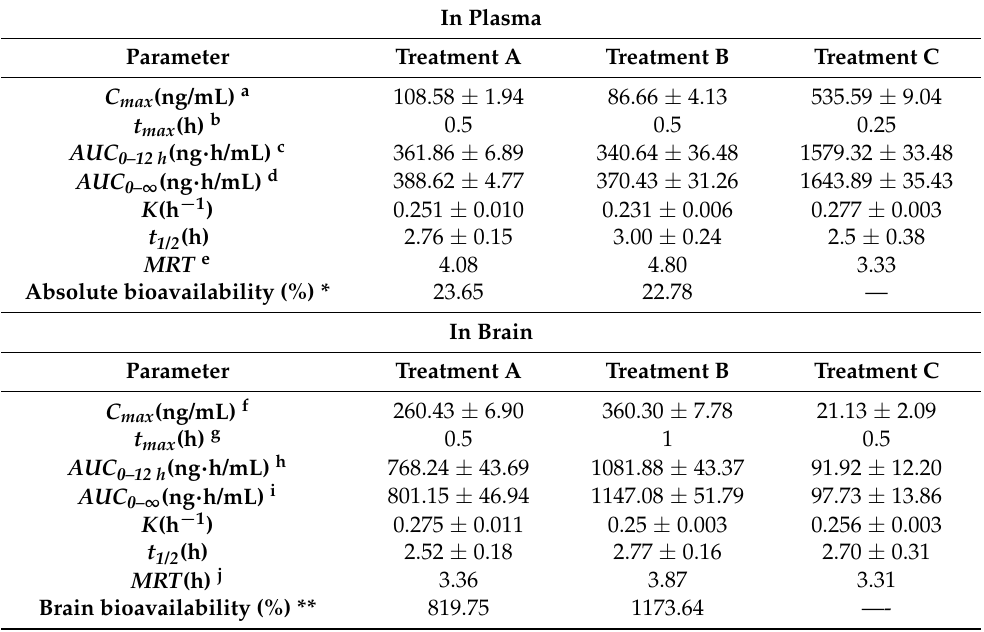
Table 6. Pharmacokinetic parameters of zolmitriptan in plasma and brain after administration of intranasal optimal bilosomes (Treatment A), intranasal mucoadhesive in situ gelling system (Treatment B) and intravenous solution (Treatment